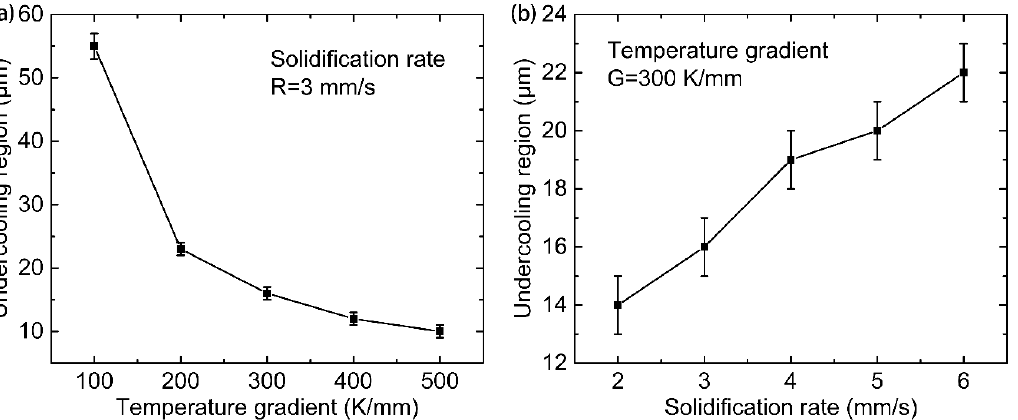
Figure 8. Size of the constitutionally undercooled region ahead of solidification front with different ( a ) temperature gradients and ( b ) solidification rates.